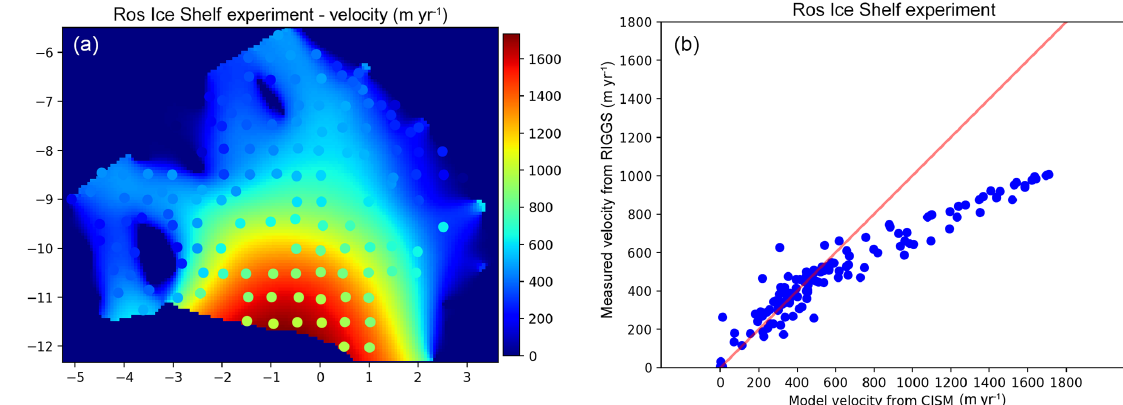
Figure 9. Results of the Ross Ice Shelf test described by MacAyeal et al. (1996), computed using Glissade’s SSA solver. Panel (a) , based on Fig. 1 of MacAyeal et al. (1996), shows the vertically uniform ice speed (myr − 1 ). The circles indicate locations where ice speed was measured by the Ross Ice Shelf Geophysical and Glaciological Survey (RIGGS); measured speeds are shaded with the same color scale as the observations. Axis coordinates match the coordinates in MacAyeal et al. (1996). Panel (b) , based on Fig. 2 of MacAyeal et al. (1996), compares simulated to measured ice speeds at the RIGGS